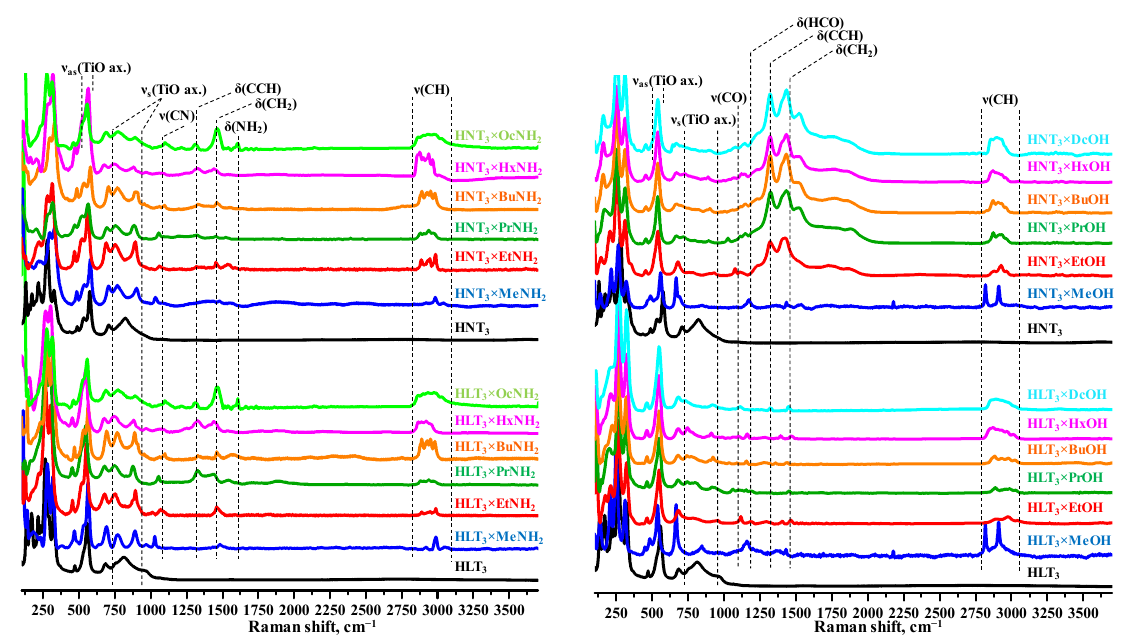
Figure 3. Raman spectra of the initial titanates and their inorganic-organic derivatives. The 13 C NMR spectra presented in Figure 4 clearly prove the successful obtainment of the inorganic-organic derivatives and confirm the absence of residual methyl and n - butylamine in the interlayer space of those, which were synthesized using corresponding amine-containing compounds as precursors. In the spectra of the derivatives with long- chain organic components (R = Hx, Oc, and Dc), some bands overlap because of close chemical shift values. Positions of the bands, referred to carbon atoms adjacent to the amine group, demonstrate a high field offset by an average of 2 ppm in comparison with those in the spectra of individual amines, which points to the existence of intercalated substances in the n -alkylammonium form. Carbon atoms adjacent to oxygen in the n - alkoxy derivatives provide bands’ offset by 16–19 ppm to the low field relative to the corresponding ones in the spectra of molecular alcohols, which serves as proof of the covalent bonding between the inorganic matrix and organic components. The n -decoxy derivative’s spectrum also contains low intensity bands at approximately 21 and 41 ppm that can be assigned neither to the n -decoxy fragment nor to residual n -butylamine since the latter is absent in accordance with the elemental analysis data. These bands might be associated with the presence in the sample of small n -decanal amount formed via the partial oxidation of n -decanol by oxygen remaining in the reaction mixture. The first of the bands might also relate to residual n -heptane molecules, which was used as a solvent in the course of the